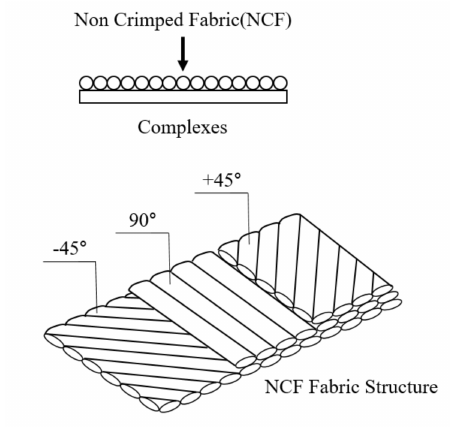
Figure 5. The dimension of boat